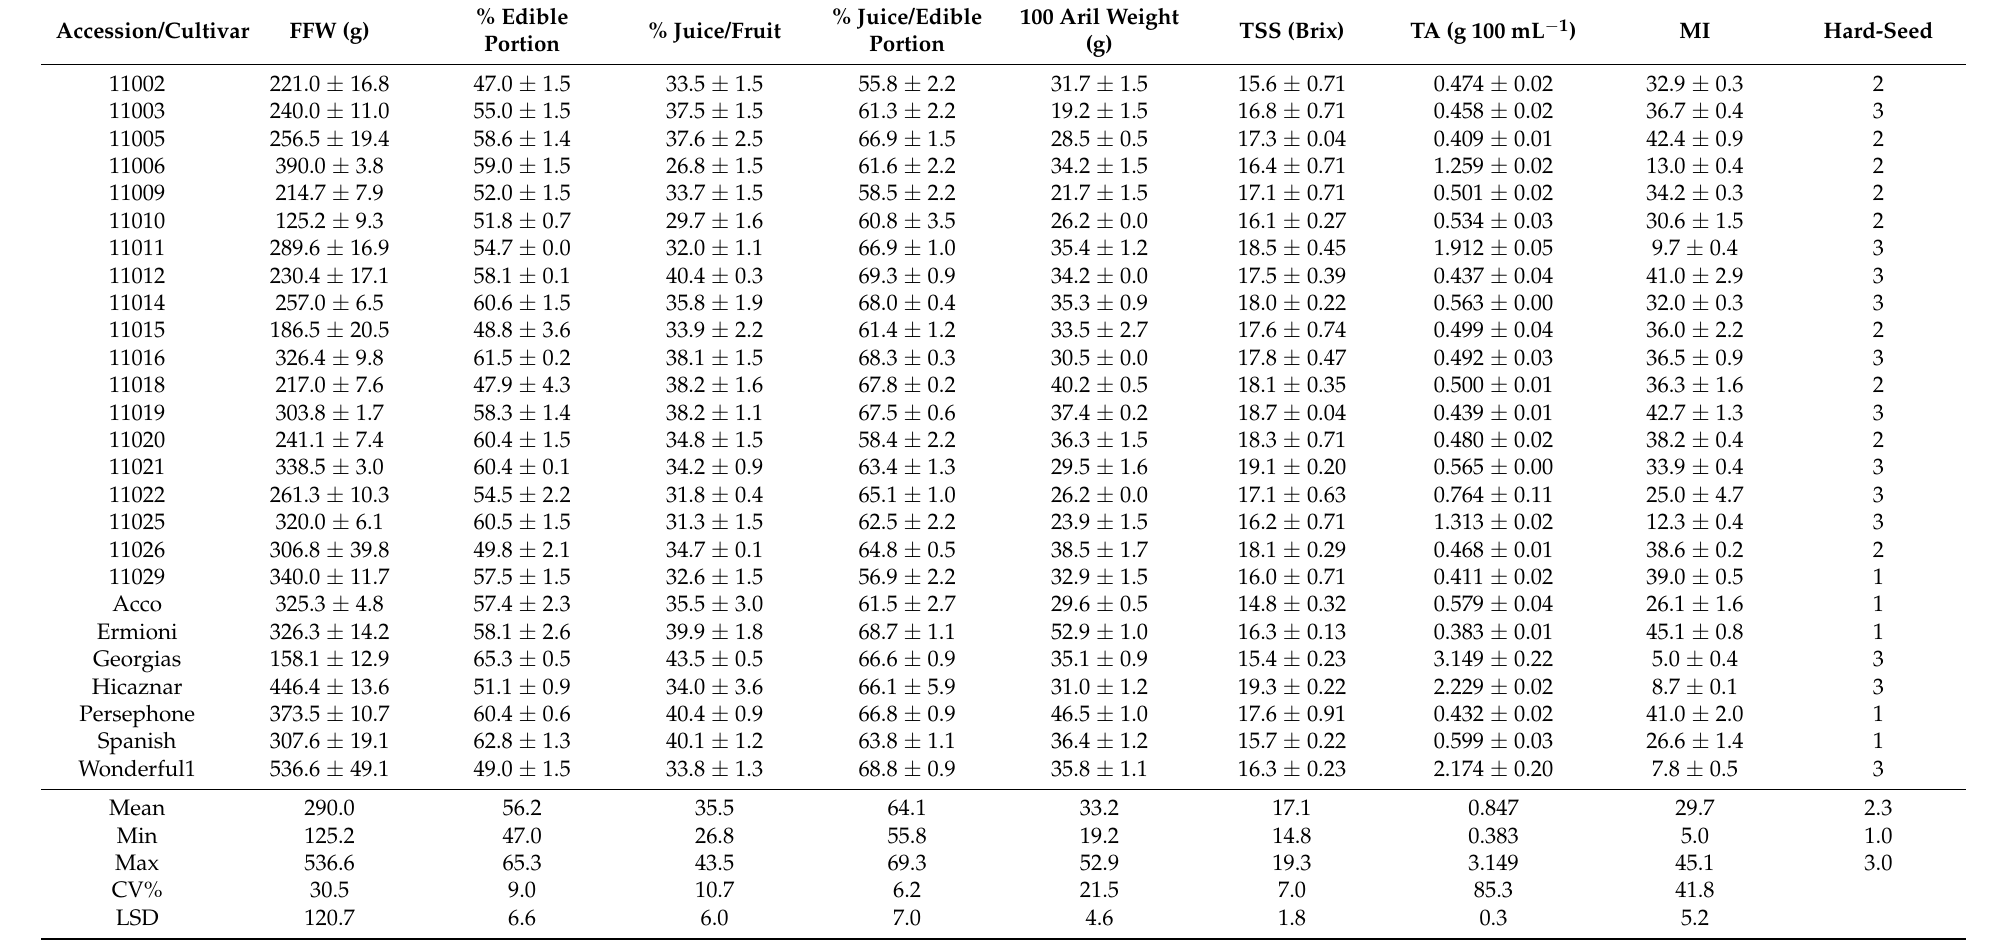
Table 2. Means ( ± sterror) for fruit fresh weight (g), % edible portion, % juice/fruit, % juice/edible portion, 100 aril weight (g), total soluble solid content (TSS) ( ◦ Brix), total acidity (TA) (g 100 mL − 1 ), maturity index (MI) (TSS/TA) and seed hardness (1 soft; 2 medium; 3 hard) in 26 pomegranate accessions/cultivars. Maximum, minimum, covariate coefficient (CV%) and least significant difference (LSD) are